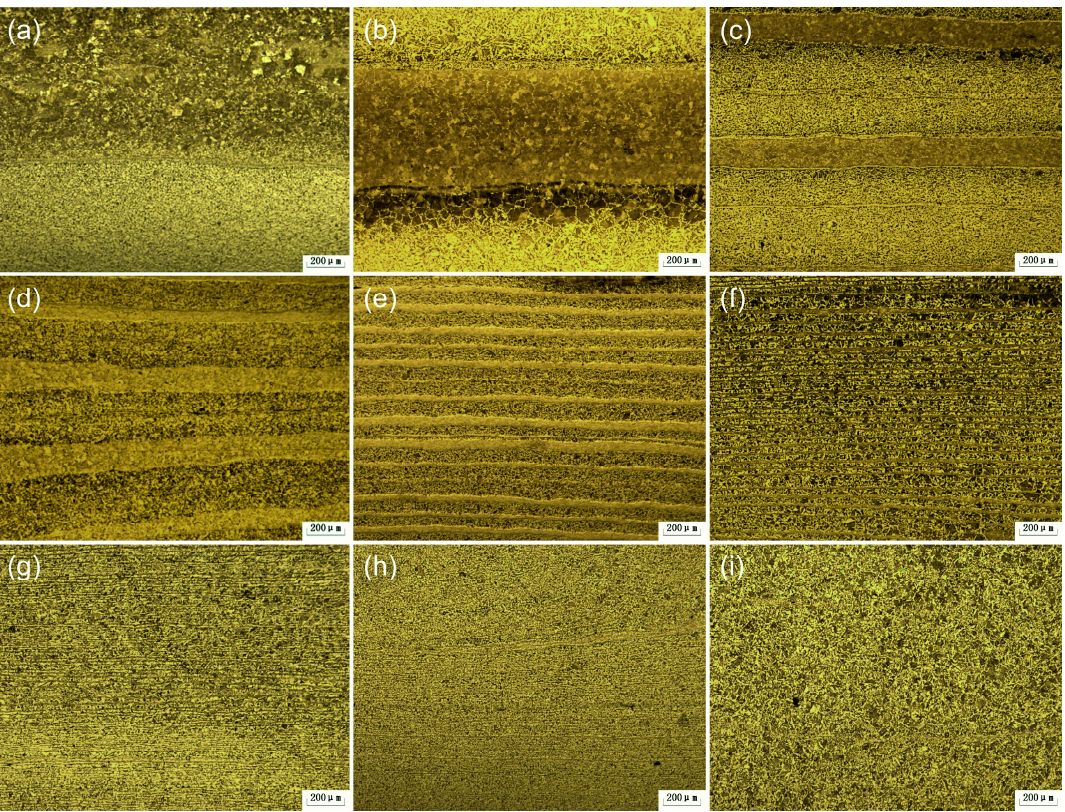
Figure 5. Continuous microstructural evolution of group 3, 50 magnification: ( a ) smelting; ( b – i ) forge welding 1–8 times.